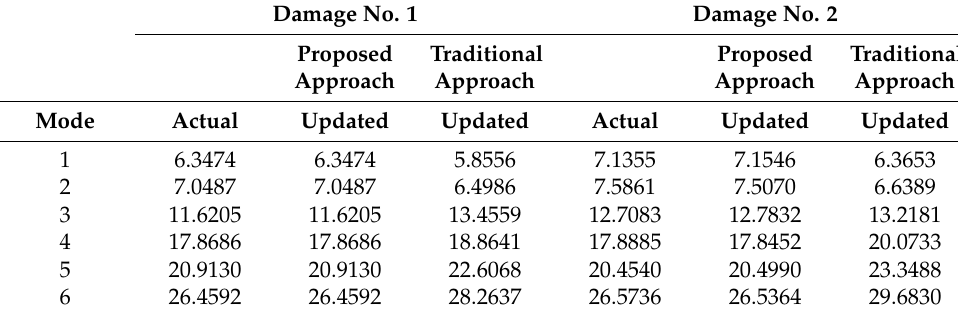
Table 8. Frequencies’ (Hz) comparison by the proposed and traditional approach.